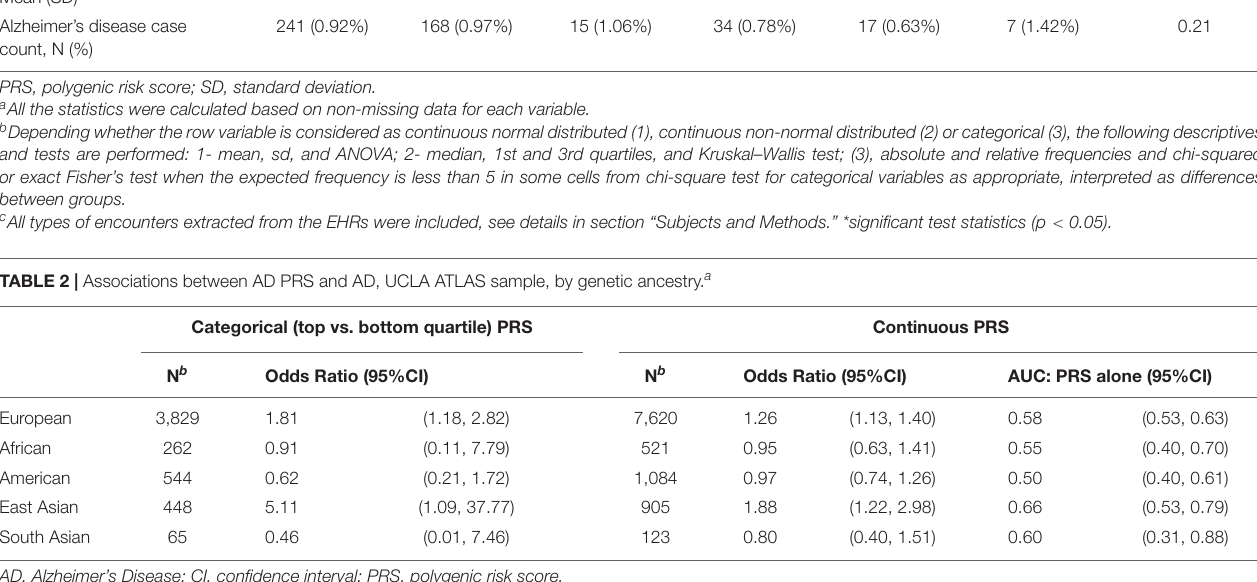
Categorical (top vs. bottom quartile)